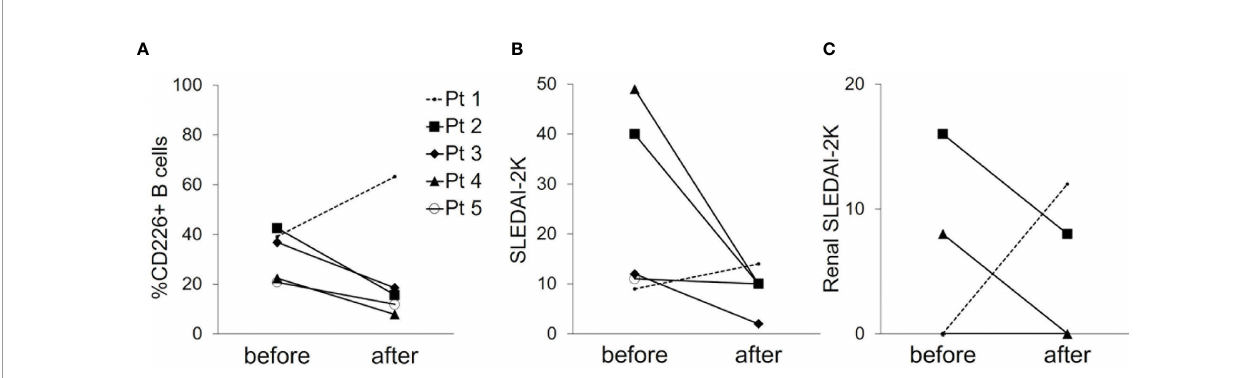
FIGURE 3 | Changes in the frequency of CD226 + B cells and disease activity before and after treatment. The frequency of CD226 + B cells (A) , SLEDAI-2K scores (B) , and renal SLEDAI-2K scores (C) before and after treatment in 5 SLE patients are shown. Each data point represents a single subject. SLEDAI-2K, SLE Disease Activity Index 2000.